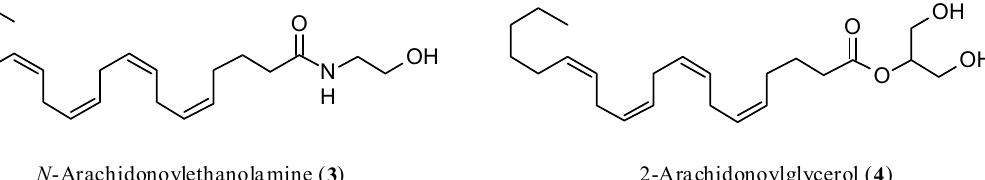
Figure 1. Chemical structures of Δ 9 -tetrahydrocannabinol (THC, 1 ) and cannabidiol (CBD, 2 ).